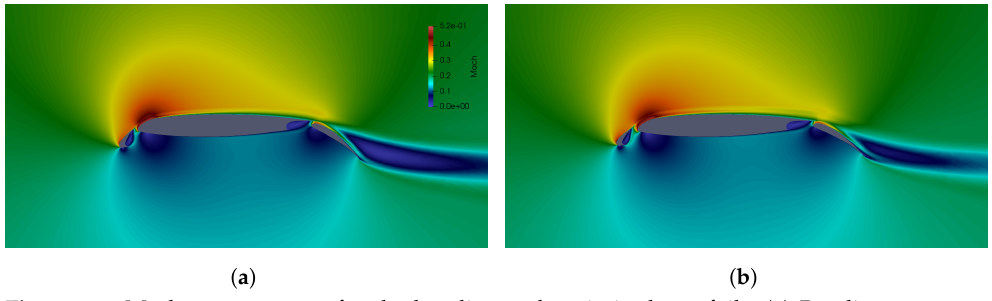
Figure 15. Mach no. contours for the baseline and optimised aerofoils. ( a ) Baseline geometry. ( b ) Optimised geometry.